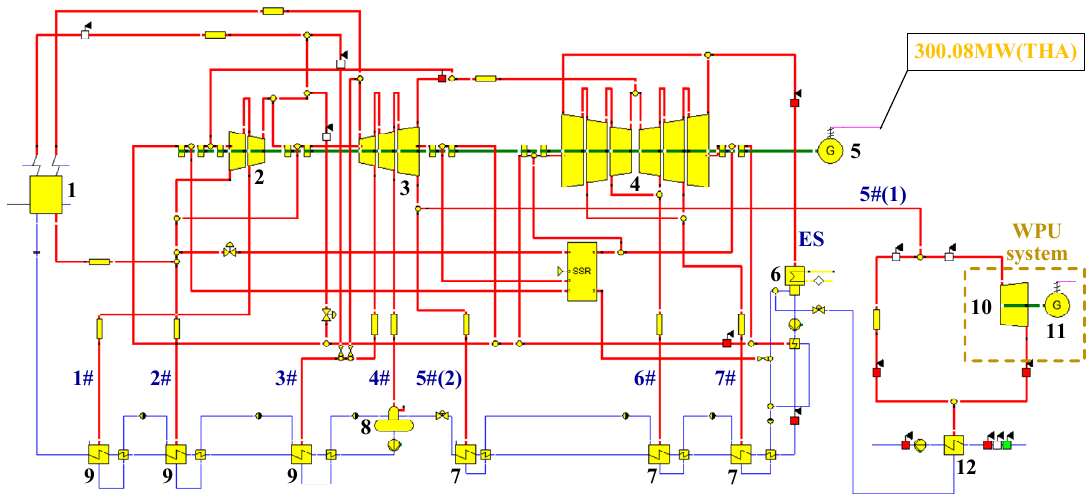
Figure 4. Simulation model of the CHP unit without or with the proposed concept. 1—Boiler;